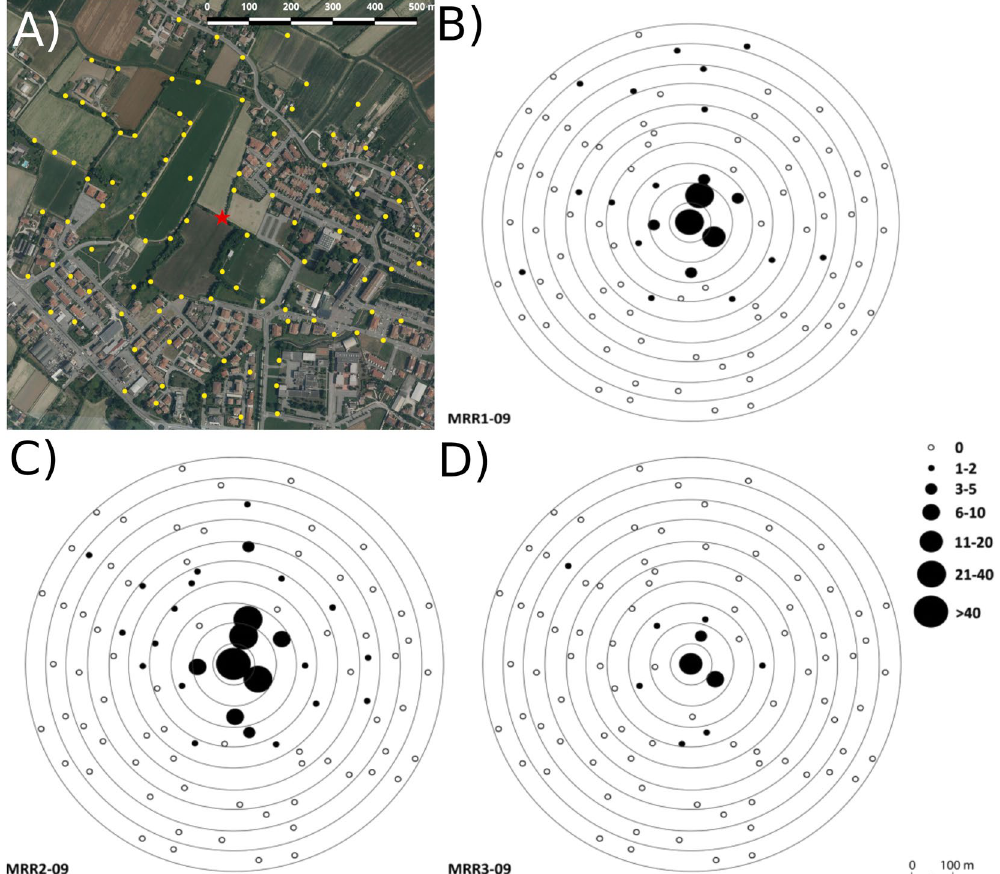
Figure 1. ( A ) Study area in Piove di Sacco (north-east Italy), where 96 sticky traps (yellow dots) were located into concentric annuli of 50 up to maximum of 500 m radius around the release point (red star). Map layout generation were done using QGIS 2.18 (QGIS Development Team (2017). QGIS Geographic Information System. Open Source Geospatial Foundation Project. http://qgis.osgeo.org) free and open source software for geographic information system. The base layer “Regione del Veneto – L.R. n. 28/76 – Formazione della Carta Tecnica Regionale” was obtained from the Veneto Region Geoportal (https://idt2.regione.veneto.it/ condizioni_utilizzo_geoportale/) distributed under Italian Open Data License 2.0 (IODL 2.0 http://www.dati. gov.it/iodl/2.0/). ( B–D) Distribution of recaptured Aedes albopictus females in the sticky-traps during the three mark-release-recapture experiments (MRR1, MRR2 and